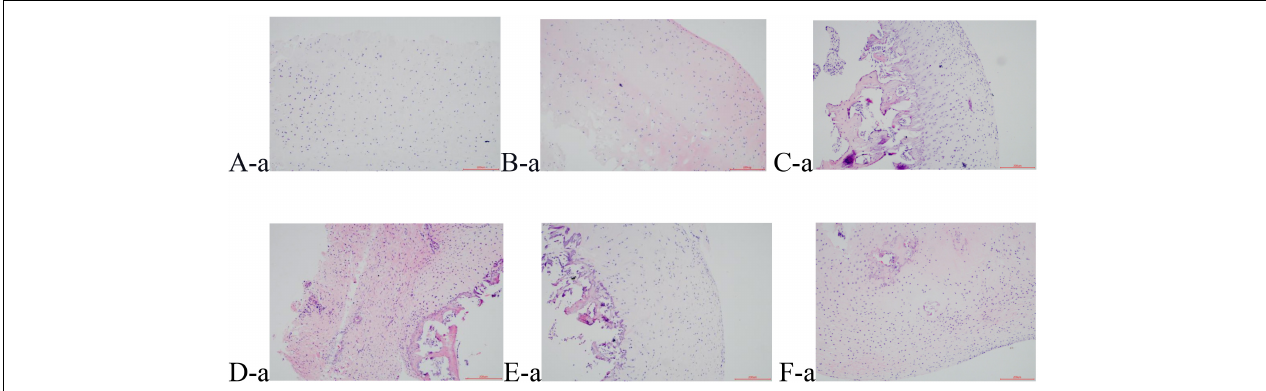
FIGURE 1 | HE staining results of cartilage tissue, (A-a) Group B; (B-a) Group S; (C-a) Group M1; (D-a) Group M2; (E-a) Group EA1; (F-a) Group EA2.